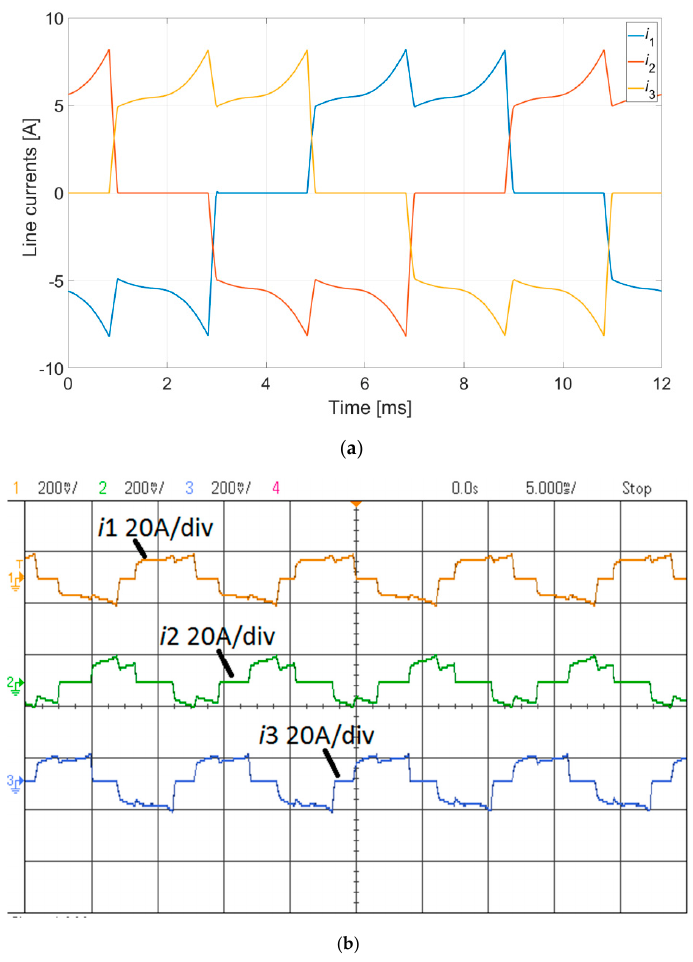
Figure 18. Star–delta (Y ∆ ) configuration—waveforms of line currents in healthy mode: ( a ) numerical calculations; ( b ) measurements.